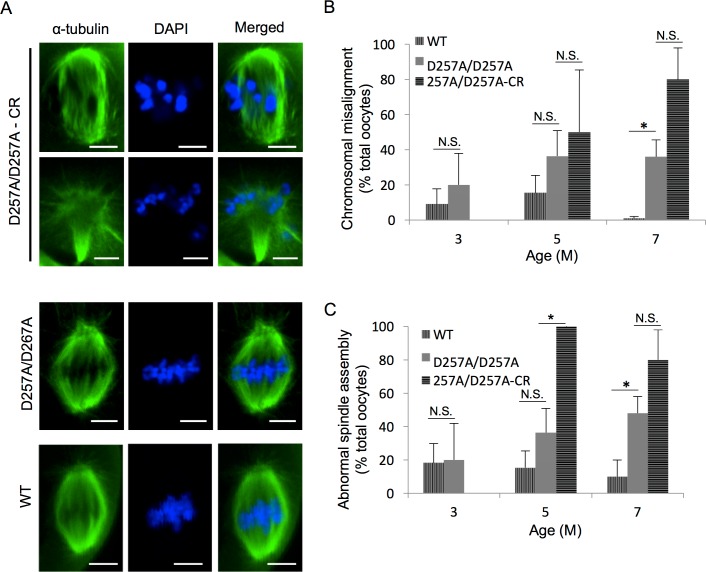
CR does not improve chromosome alignment or meiotic spindle assembly in oocytes from POLGD257A/257A mice.A. Representative laser scanning confocal micrographs of meiotic spindles in MII oocytes from WT, 7-month-old POLGD257A/257A, and POLGD257A/257A-CR mice; α-tubulin labeling of spindle (green) and DNA labeled with DAPI (blue). Scale bars = 5 μm. B, C. Percentage of chromosome misalignment and abnormal spindle assembly in oocytes from WT, POLGD257A/257A, and POLGD257A/257A-CR mice collected at 3–9 months of age (mean shown, error calculated as SD of a binomial distribution; only MII analyzed, oocytes were from 3–6 mice per group; N.S., not significant; P > 0.05; * P < 0.05).